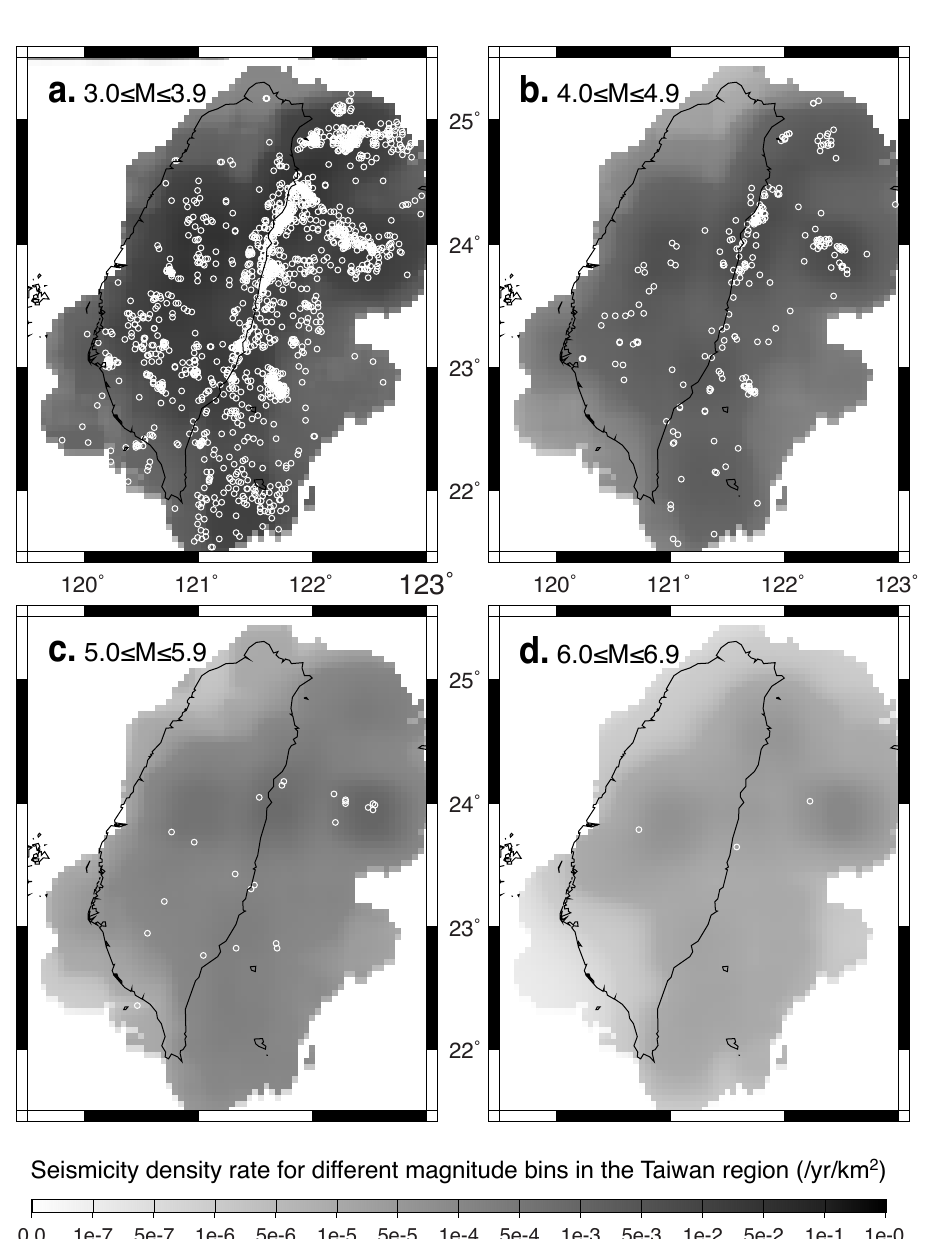
Figure 6 Fig. 6. The distribution of the reference seismicity rate acquired for different magnitude ranges. Forecasting earthquakes are shown as white